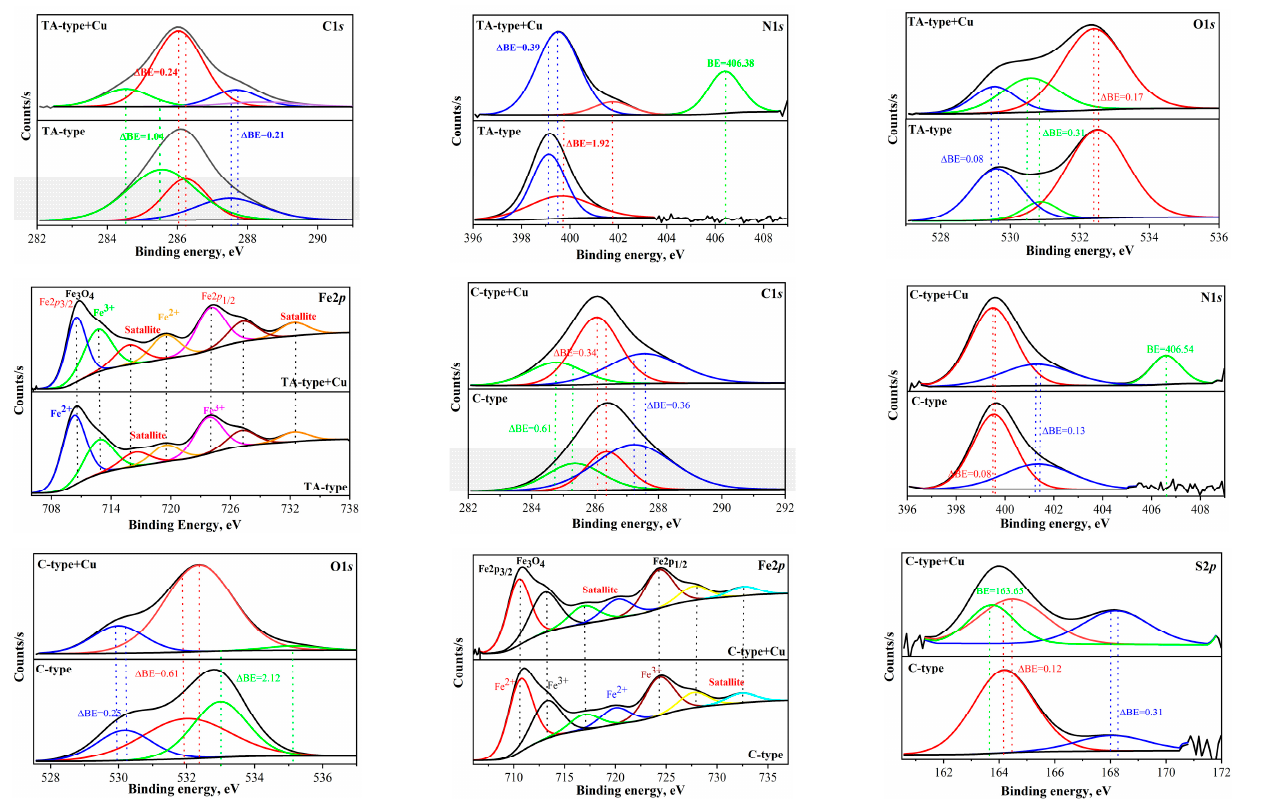
Figure 3. HR-XPS of TA-type and C-type for (C1 s , N1 s , O1 s , Fe2 p , and S2 p spectra) before and after Cu(II) adsorption. Cu(II)